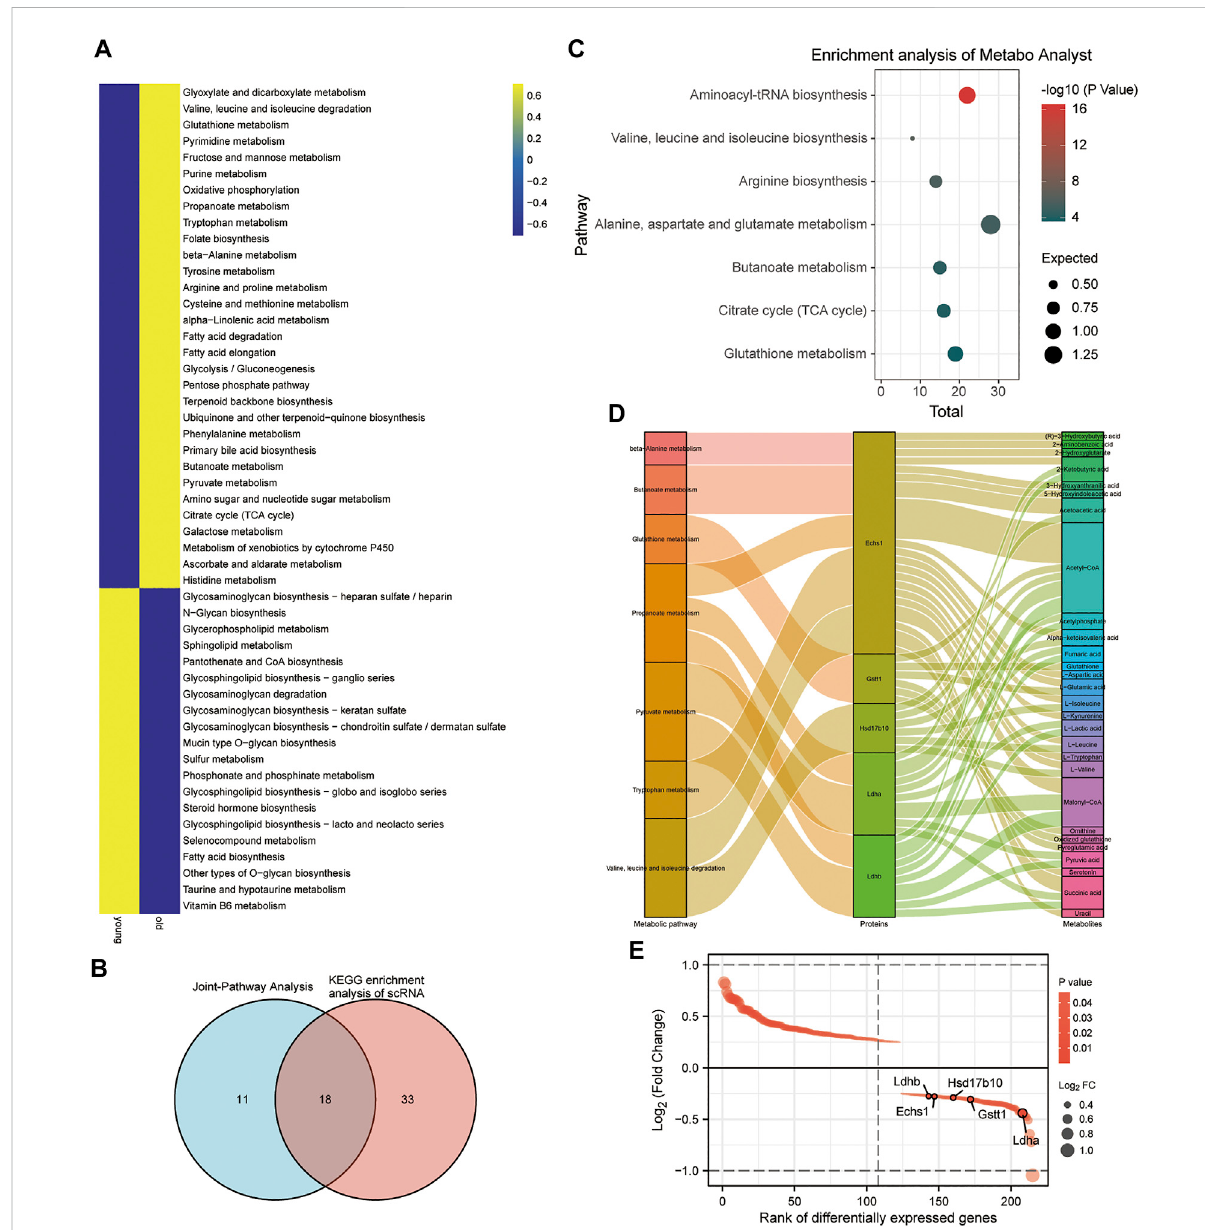
FIGURE 4 Metabolic differences in mouse brain CPC in the older versus younger groups. (A) Heat map showing CPC metabolic pathway scores based on scMetabolism. (B) Venndiagramshowing29metabolicpathwaysinCPC(showninFigure1)enrichedbyMetaboAnalyst ’ sJoint-PathwayAnalysisand 18 intersections of 51metabolicpathwaysfrom KEGGbased on scMetabolism. (C) Blisterplotsshowing 7ofthe18 intersecting pathways (Figure 4B) are upregulated in the activity of aged mouse CPC. (D) Sankey plots showing the seven metabolic pathways regulated by fi ve CPC age-related differential genes ( Ldhb, Echs1, Hsd17b10, Gstt1, and Ldha ) and the differential metabolites they affect. (E) Demonstrates the rank of the fi ve age- related differential CPC genes ( Ldhb, Echs1, Hsd17b10, Gstt1, and Ldha ) downregulated in the younger